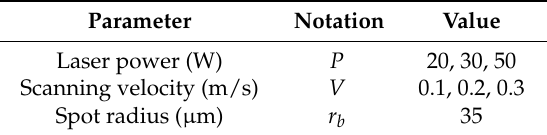
Figure 6. ( a ) Temperature history for a given point which is a distance of 250 μ m away from the start point; ( b , c ) temperature distribution (unit in K) from the model with and without considering the effect of material state and phase changes on laser absorption, respectively. P = 50 W, V = 0.1 m/s, r b = 35 μ m.